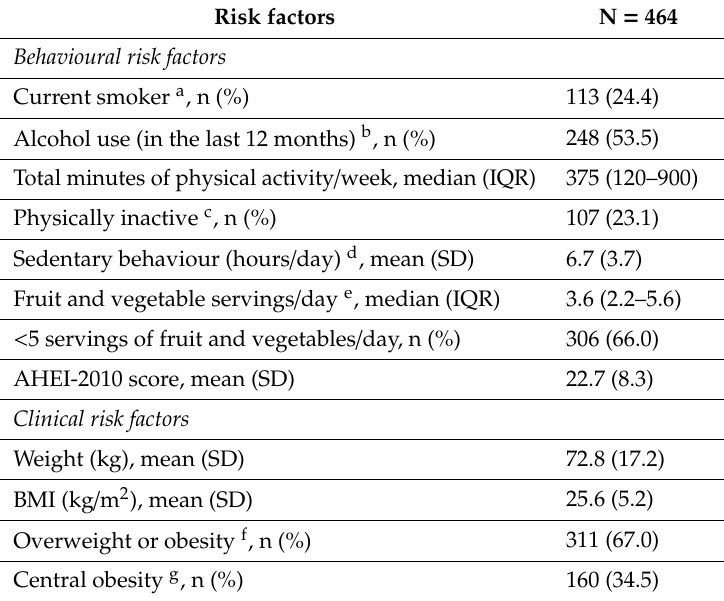
Table 2. Behavioural and clinical risk factors for non-communicable diseases at baseline. Risk factors N =